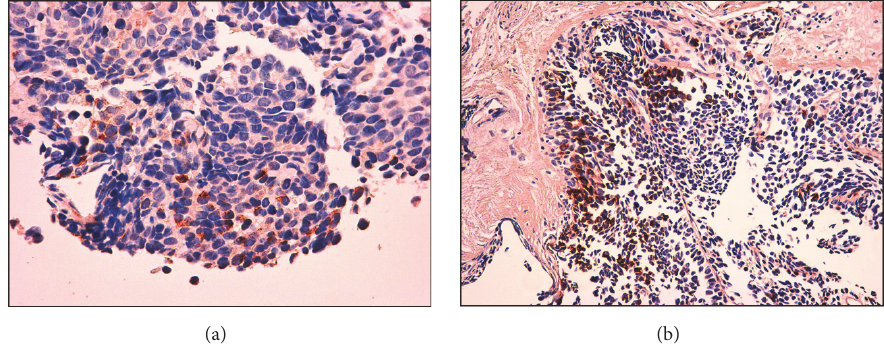
Figure 3: (a) Immunohistochemical stain showing tumour cell positive for ACTH ( × 40). (b) Immunohistochemical stain showing tumour cell positive for calcitonin ( ×